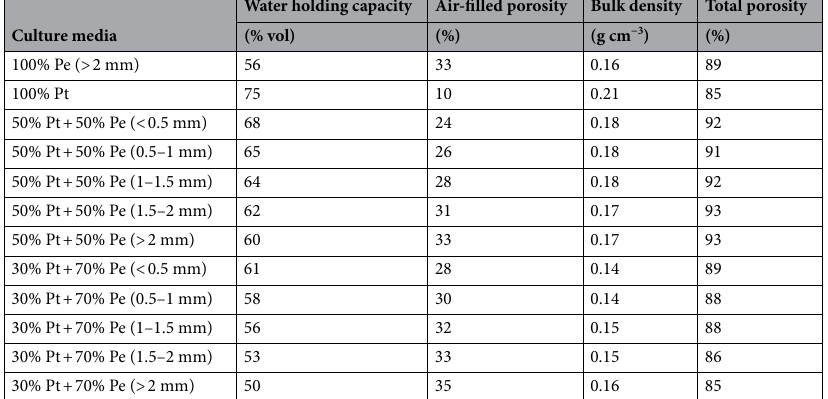
Table 6. Physical properties of media used in greenhouse E. purpurea culture. The numbers in the parentheses show perlite particle size. Pt peat moss and Pe perlite.